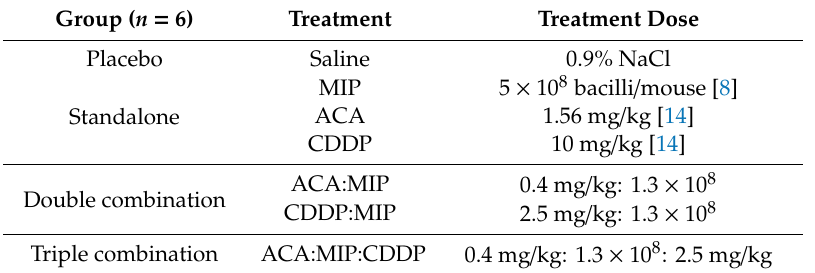
Table 1. The di ff erently treated groups of mice and dosages for the in vivo animal